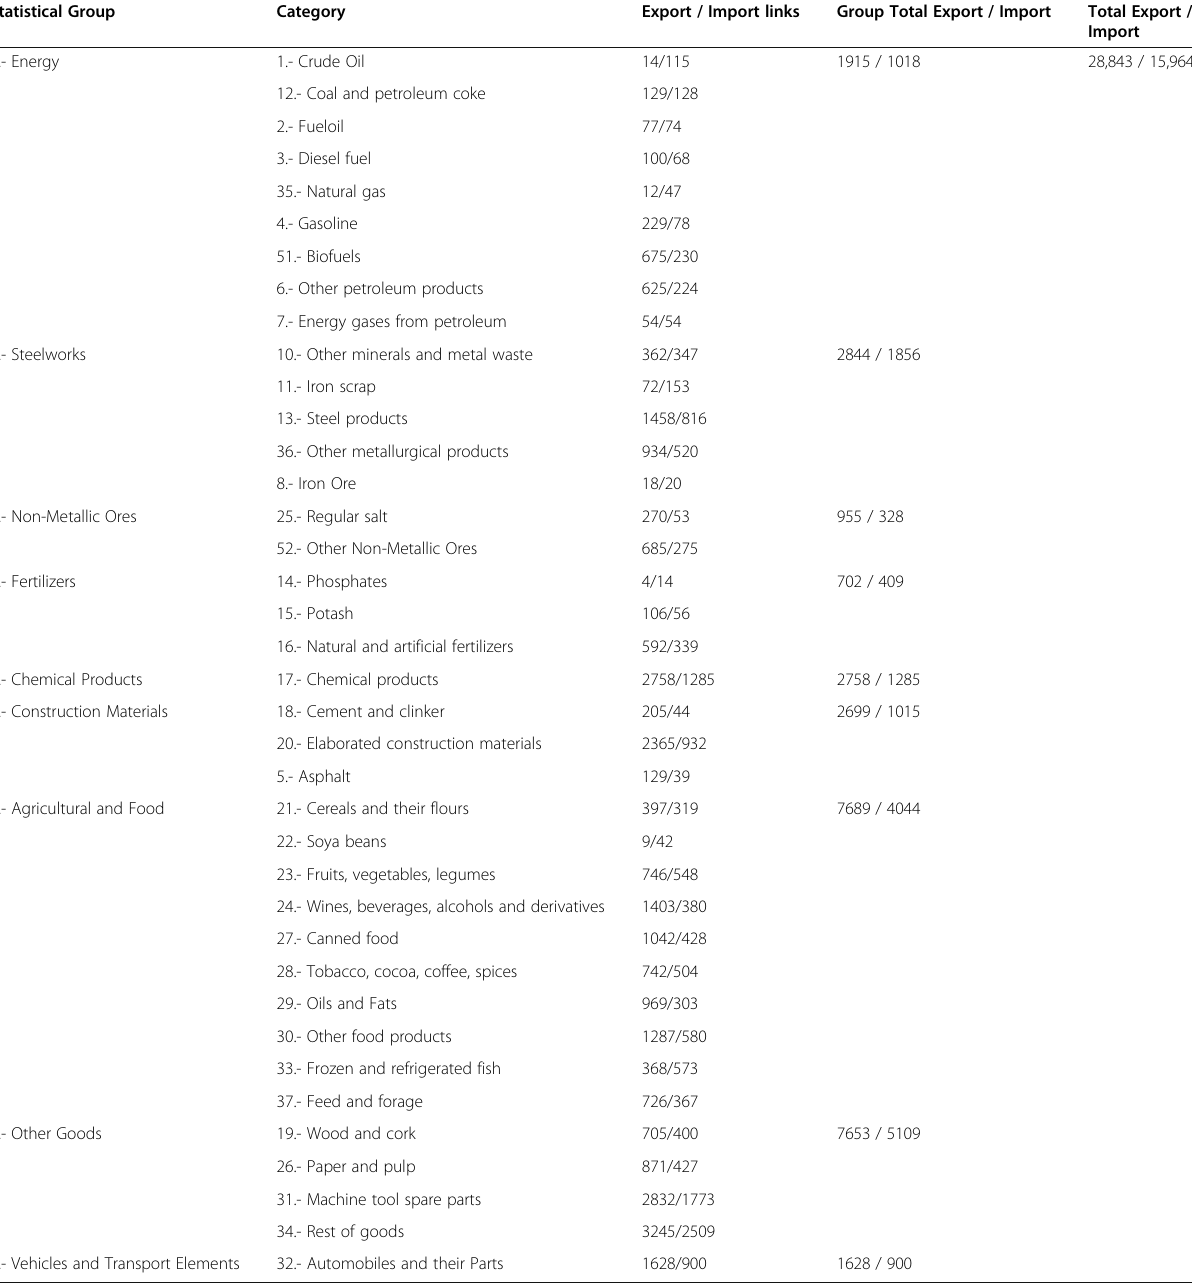
Table 1 Number of Export/Import links in the bipartite graphs corresponding to each type of product, in 2019 Statistical Group Category Export / Import